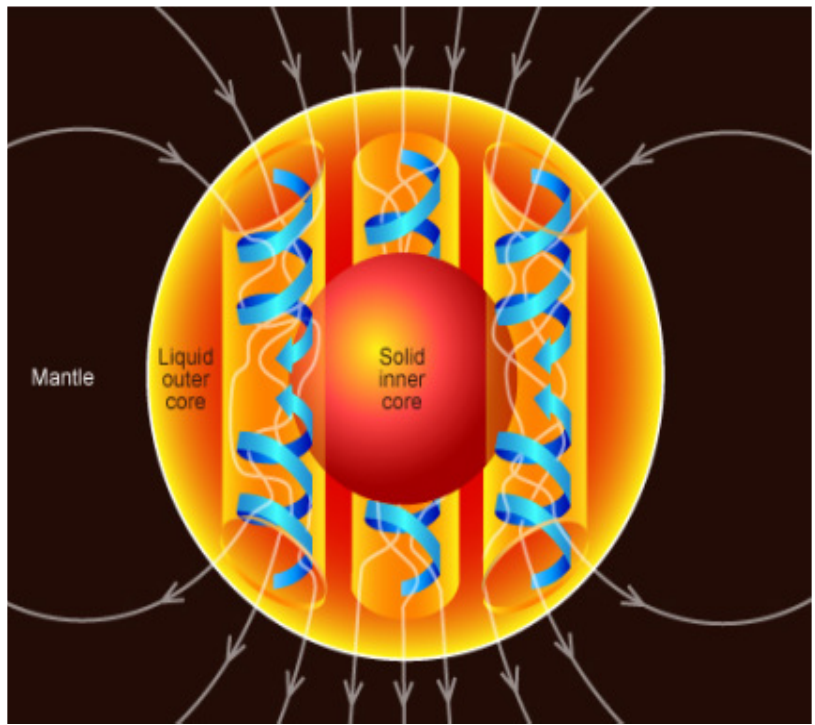
Figure 3. The Earth’s dynamo (https://www.abc.net.au/ photo from the ABC (Australian Broadcast- ing Corporation, accessed on 15 October 2022).